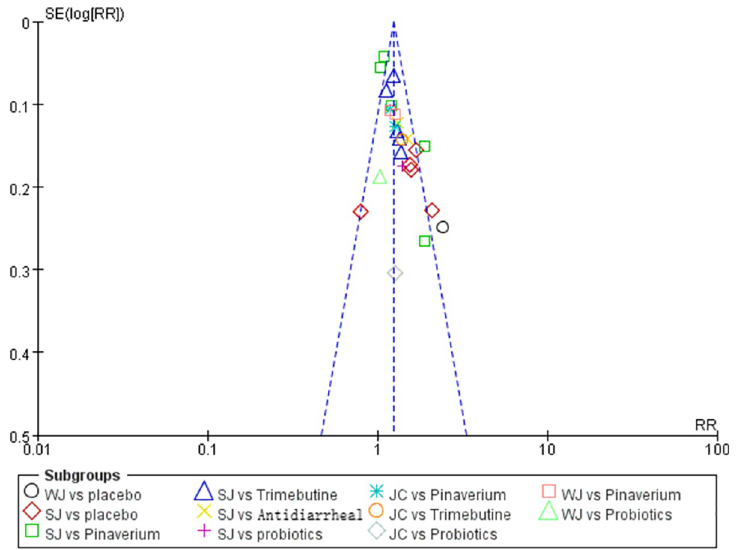
Fig 6. Funnel plot. JC: Jianpi-Chushi therapy; SJ: Shugan-Jianpi therapy; WJ: Wenshen-Jianpi therapy.